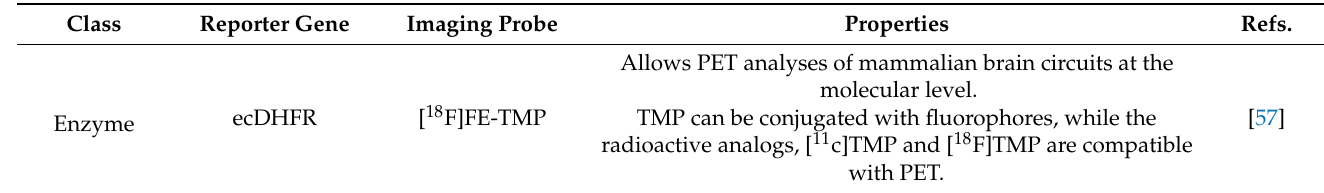
Table 3. Reporter genes and corresponding radiotracer in radionuclide brain